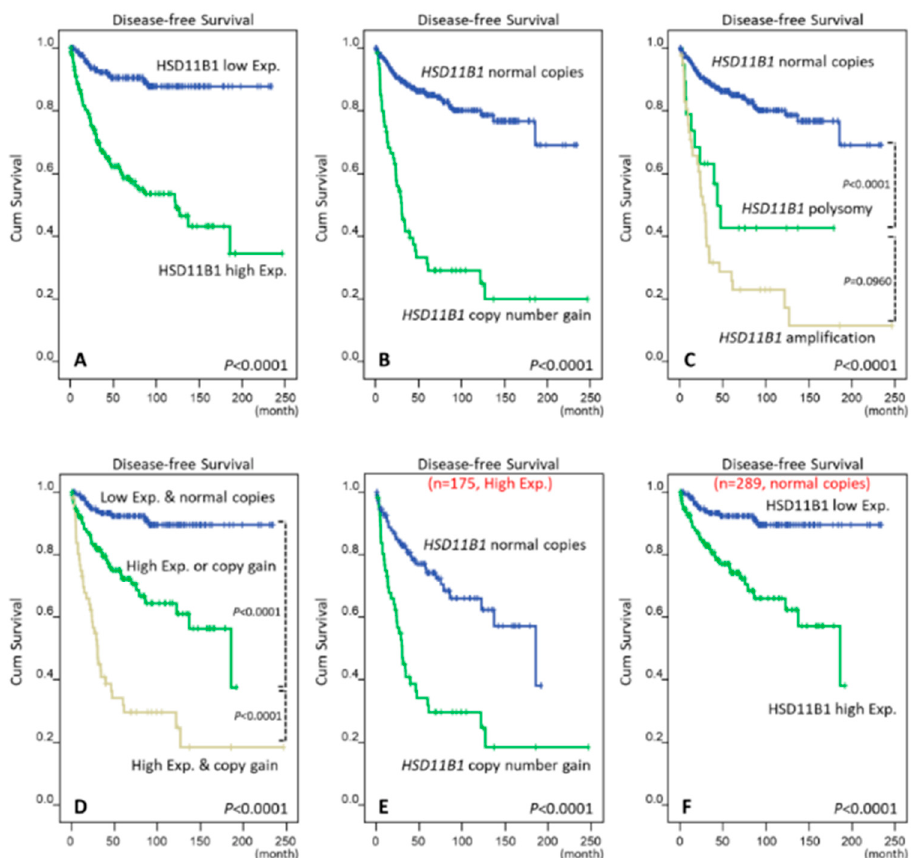
Figure 3. Kaplan-Meier analyses of univariate disease-free survival (DFS) in primary gastrointestinal stromal tumors (GISTs). In all the 350 cases, survival curves were plotted based on ( A ) hydroxysteroid 11-beta dehydrogenase-1 (HSD11B1) immunohistochemical H-scores; ( B ) dichotomy of normal copies versus HSD11B1 copy-number gain (CNG); and ( C ) trichotomy of normal copies, polysomy, and amplification with remarkable prognostic variation between normal copies and polysomy that exhibits contrast with the comparison between polysomy and amplification; ( D ) Comparison among cases with neither, either or both aberrations of CNG and high HSD11B1 expression; In sub-cohort analyses, HSD11B1 CNG ( E ) robustly distinguished GISTs with shorter disease-free survival among 175 cases with high HSD11B1 expression, as high HSD11B1 expression; ( F ) did among 289 cases with normal HSD11B1 gene copies. Exp., expression.